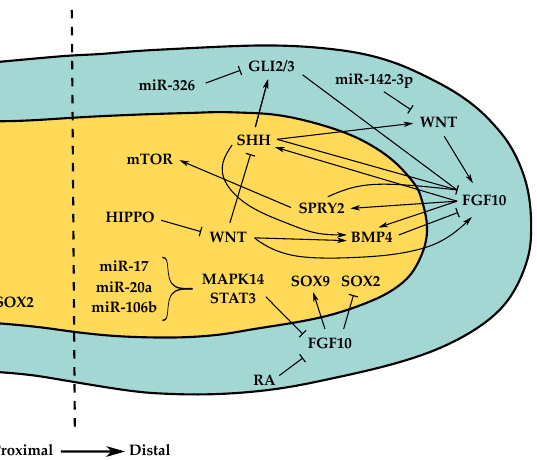
Figure 2. Signaling pathways that mediate epithelial–mesenchymal interactions during pseudoglan- dular stage, specifically in the distal epithelial tip. SOX2+ cells define proximal epithelial cell lineages whereas SOX9+ cells define distal epithelial cell lineages. Yellow, epithelium; blue,